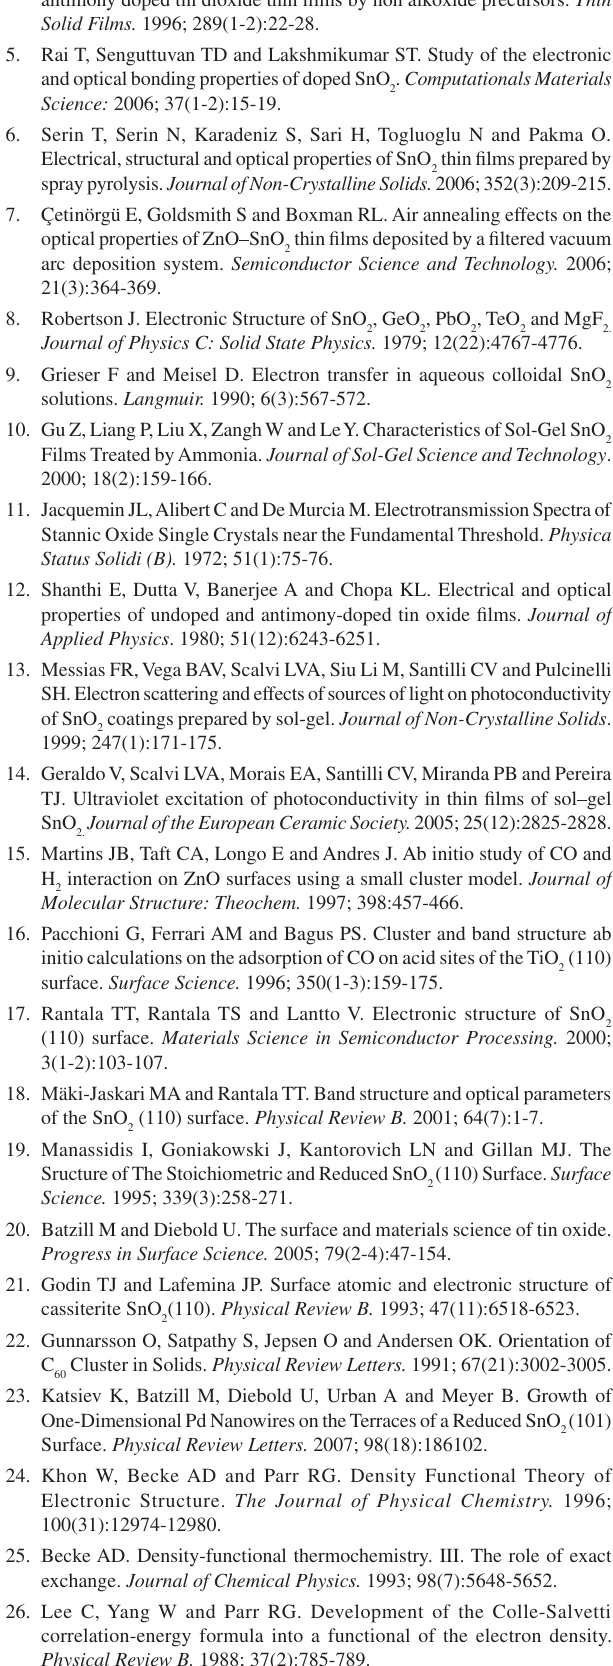
Figure 7c, 7d and 7e represents the band structure for surface (110), the high-symmetry paths of the adequate 2D Brillouin zone and the band structures for surface (101),